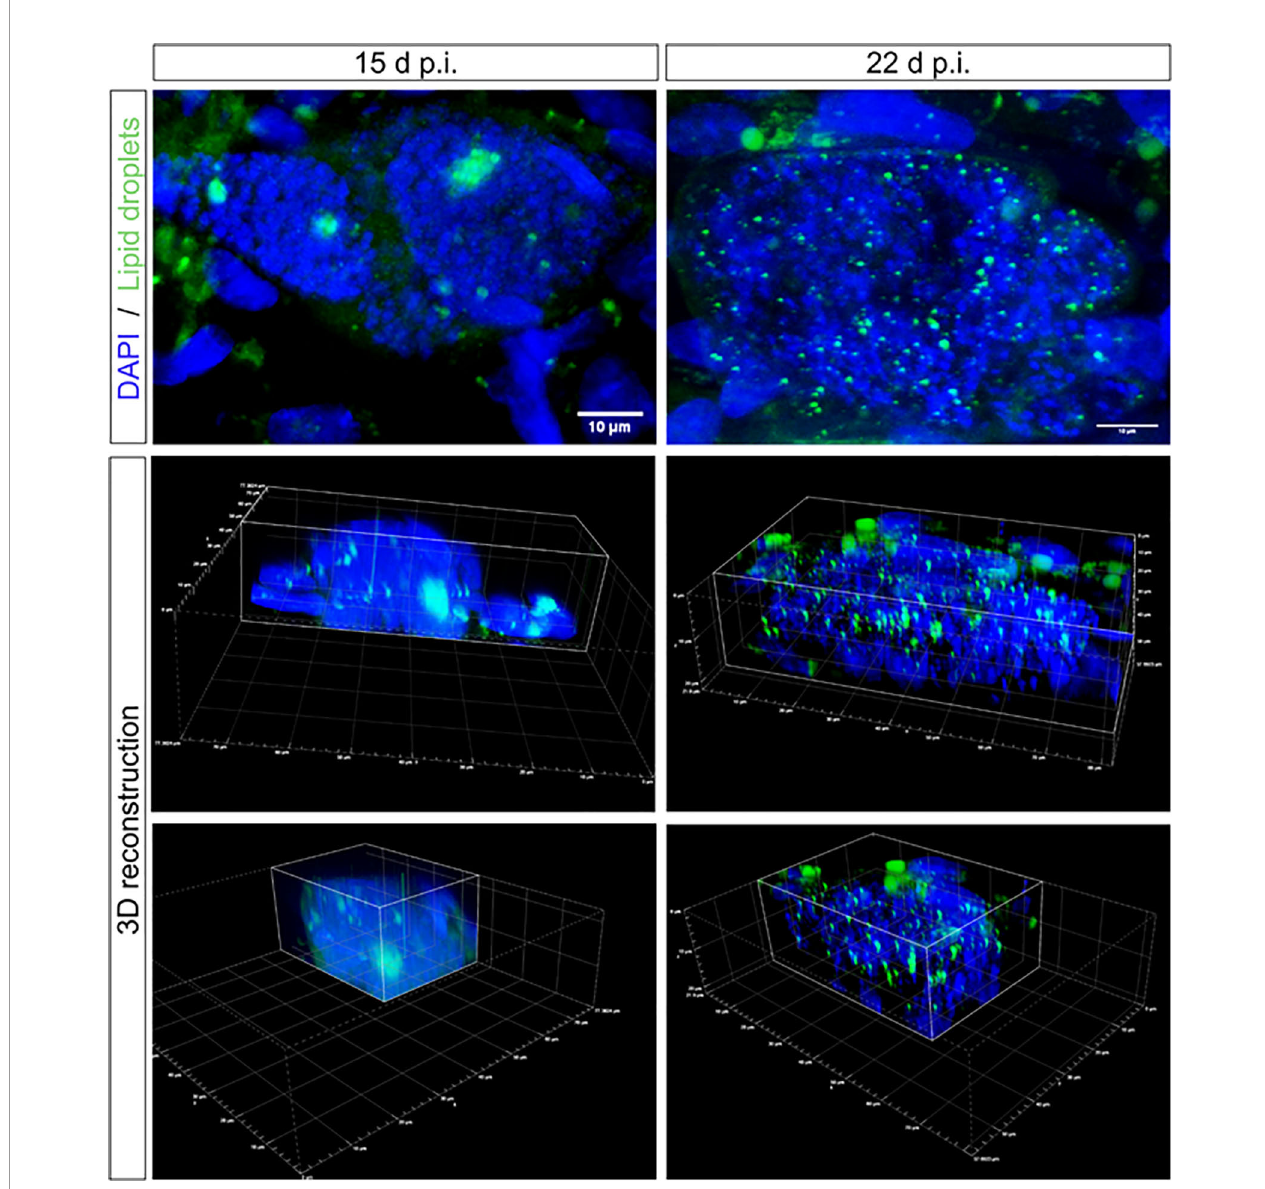
FIGURE 2 | Lipid droplet distribution in E. bovis macromeronts. Confocal microscopy analysis evidenced the presence of large lipid droplets being positioned as large clusters in immature macromeronts at day 15 p.i. In contrast, in mature macromeronts (22 d p.i.), numerous small lipid droplets (green) were evenly distributed in the parasitic compartment as also illustrated by 3D reconstructions. DAPI (blue) was used to stain DNA. Scale bar 10